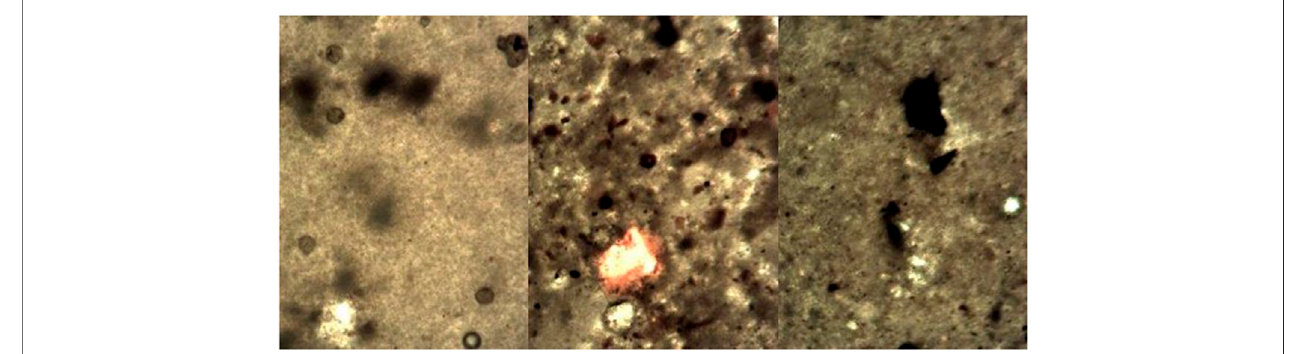
FIGURE 4 | Microscopic morphology of PEM drilling fl uid treated with inorganic fl occulant.